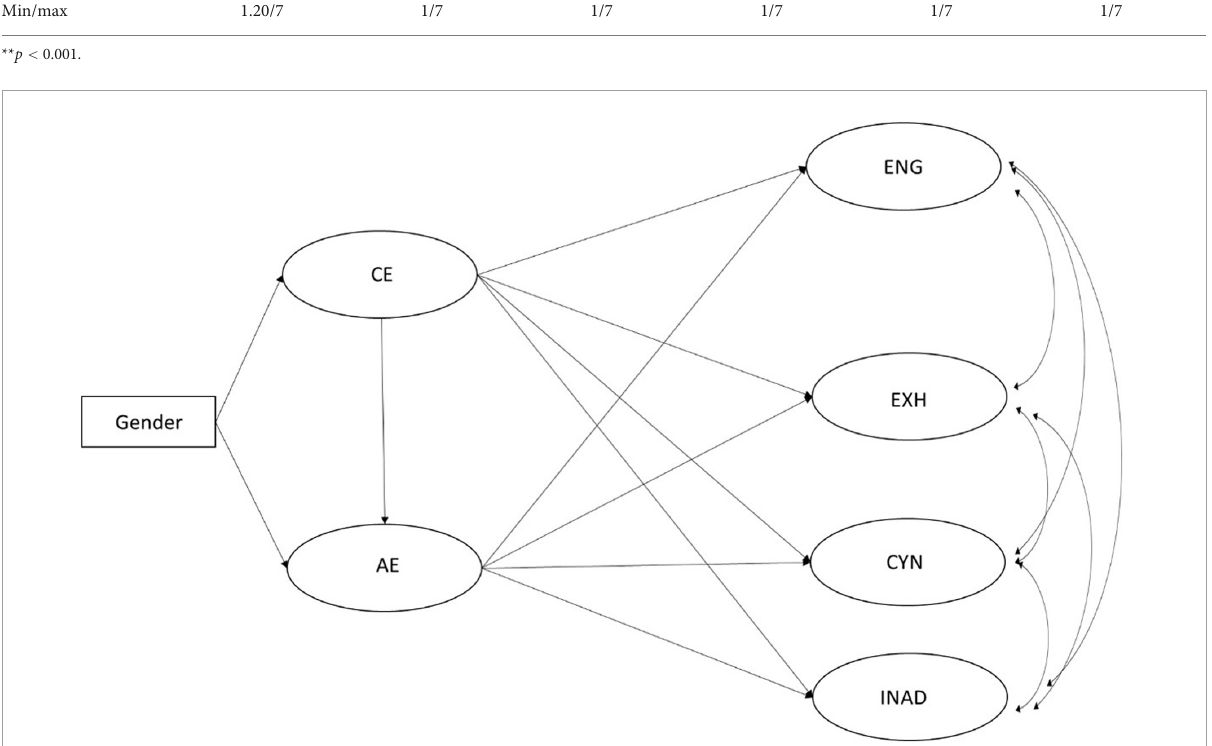
FIGURE1 Hypothesized model of the interrelations between the dimensions of empathy and study wellbeing.